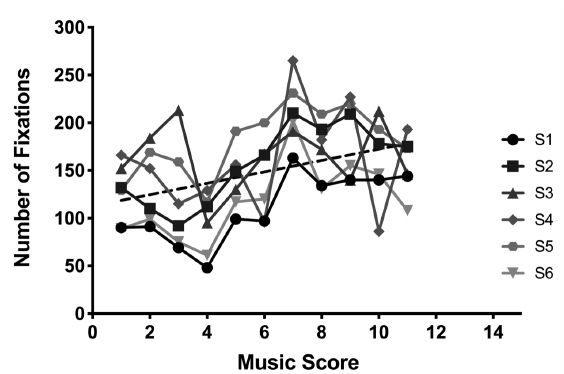
Figure 1. Number of fixations as a function of music score.